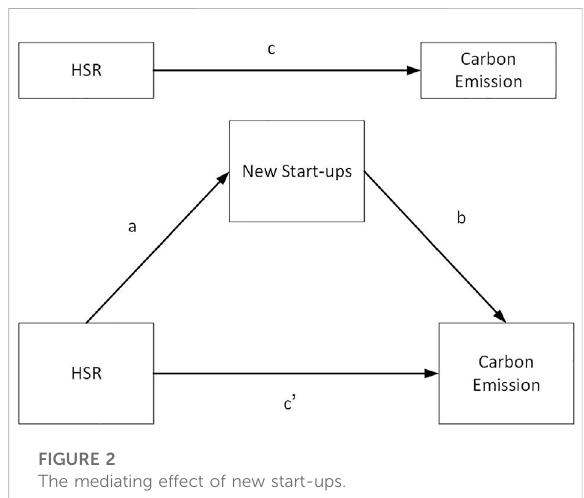
FIGURE 2 The mediating effect of new